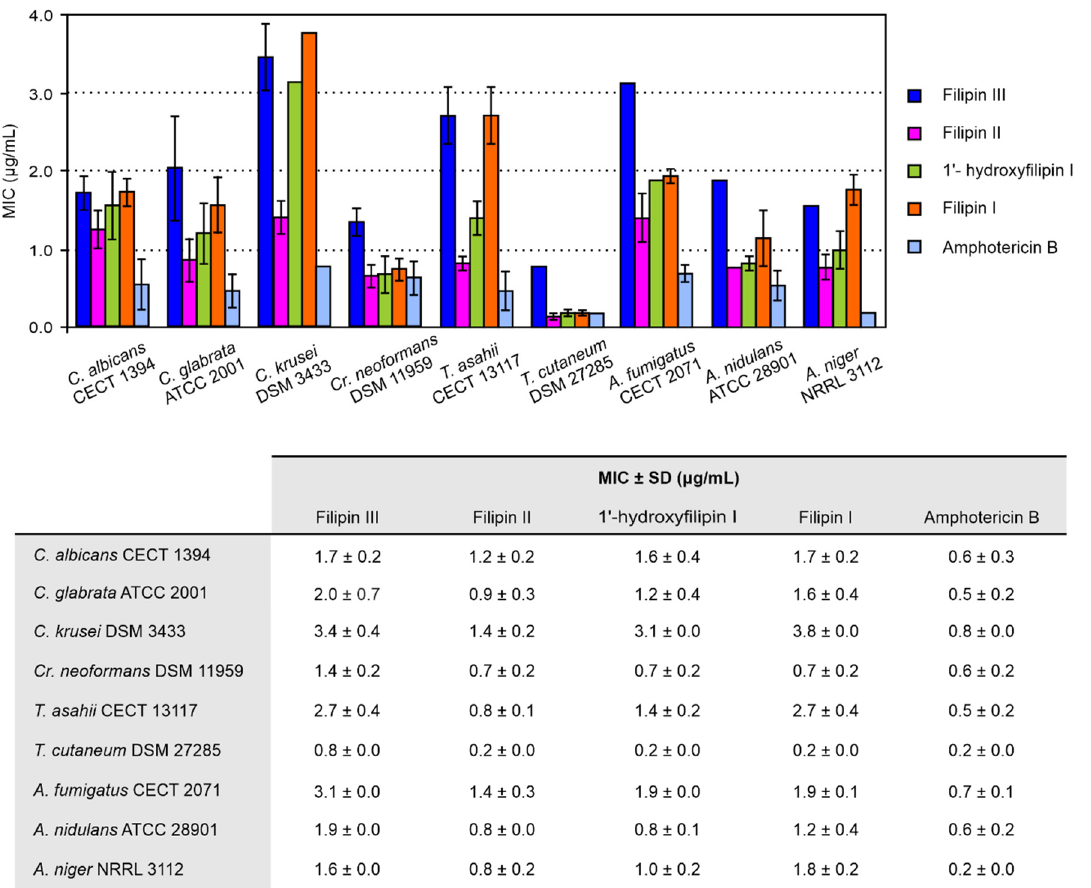
Figure 2. Minimum inhibitory concentrations (MICs) of filipin III intermediates. Data are the average of three determinations from independent experiments. MICs of amphotericin B were determined under identical conditions. Vertical bars indicate the standard deviation (SD) values. All compounds were fungicidal at the